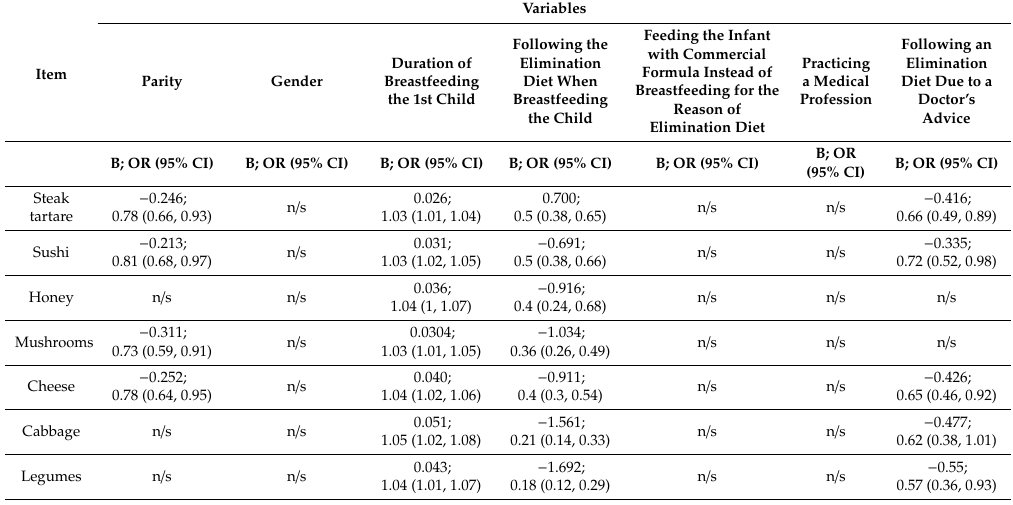
Table 2. Statistically significant factors with an influence on the opinions regarding whether a mother is allowed to consume particular foods while breastfeeding. Multiple regression analysis, p < 0.05.